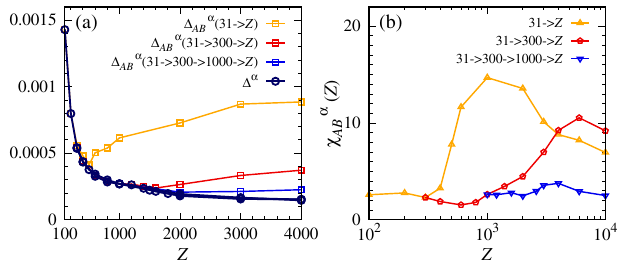
FIG. 13. Evolution of long-time limits of the MSD and the average distance between clones against pressure for various protocols. (a) The gap between Δ α and Δ α emerges at a pressure AB that strongly depends on the protocol, which appears to shift the location of the Gardner crossover from Z ≈ 200 to Z ≈ 2000 . (b) The corresponding susceptibilities χ α have a maximum that AB shifts to larger pressure and decreases as the protocol is made more